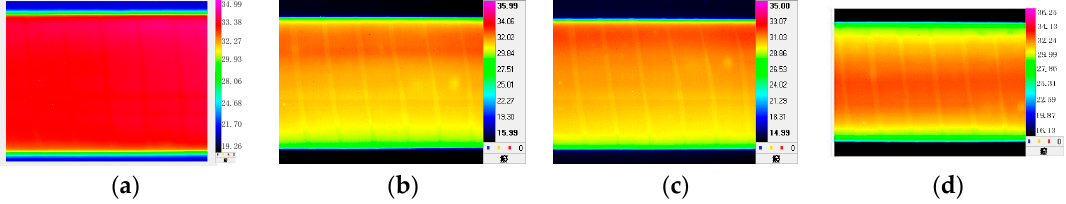
Figure 12. Infrared images of cable surface temperature: ( a ) normal, ( b ) case 1, ( c ) case 2, ( d ) case 3.